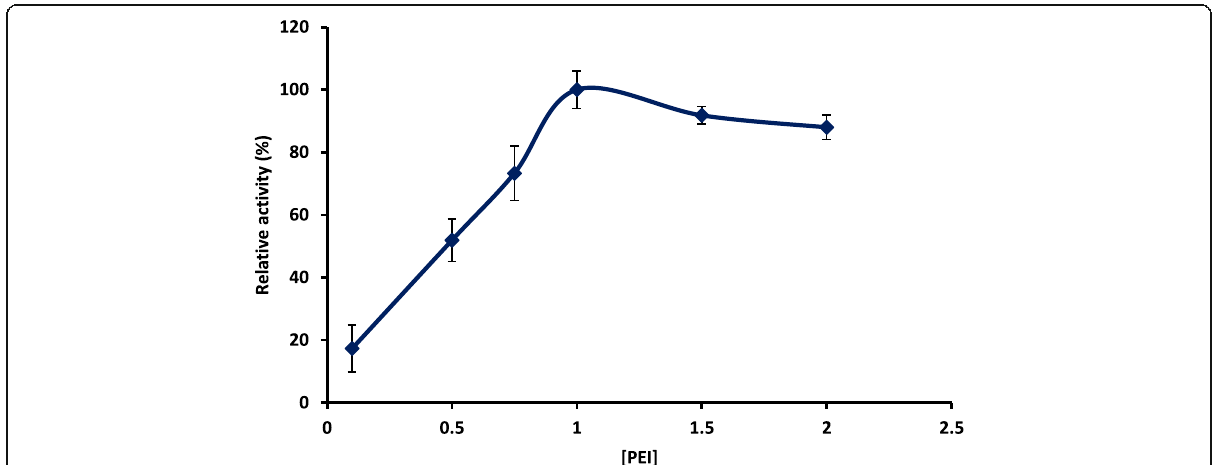
Fig. 2 Effect of variation of PEI concentration on the catalytic activity of immobilized enzyme